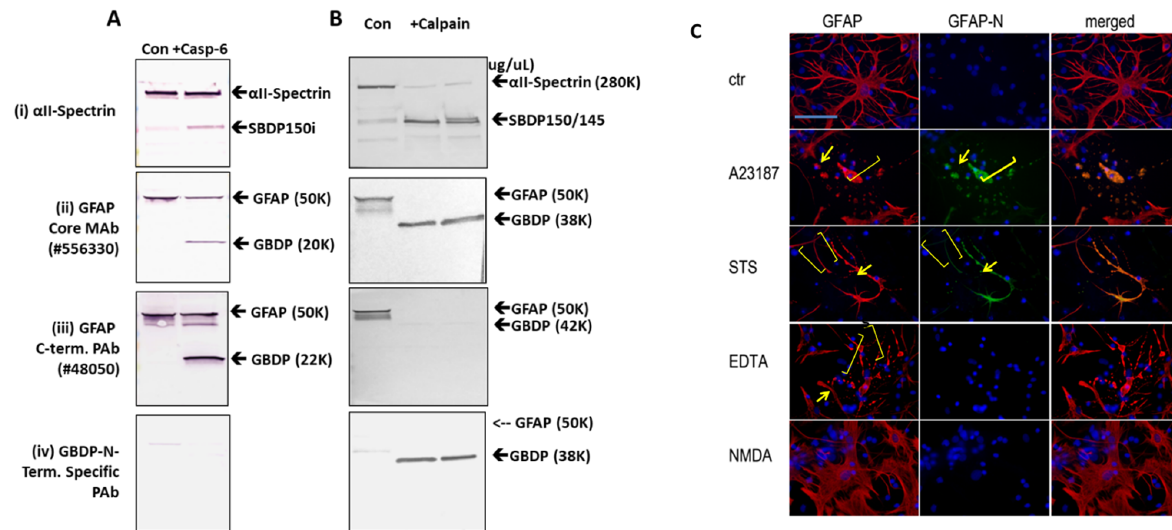
Figure 4. Characterization of calpain-derived GBDP (38K)-N-terminal specific antibody: immunoblotting of in vitro digest of GFAP in cerebrocortical neuron-astroglia mixture lysate with caspase-6 ( A ) vs. calpain-1 ( B ). Characterization of αII-Spectrin, GFAP core, and C-terminal antibodies and calpain-derived GBDP (38K)-N-terminal specific antibody. ( C ) Immunocytochemical characterization of rat primary astroglia cells labeled with total GFAP and GBDP-specific antibodies. Rat primary astrocytes subjected to A23187, STS, EDTA, or NMDA were stained with anti-GFAP core MAb, GBDP-N-terminal specific antibody. Yellow arrows show distinct GBDP-staining of the astrocyte cell body. Yellow brackets show degenerative astrocyte